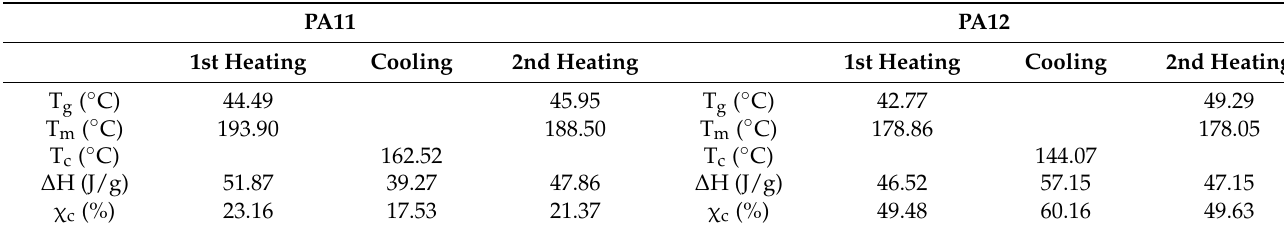
Table 4. Thermal properties of studied polyamides by DSC.